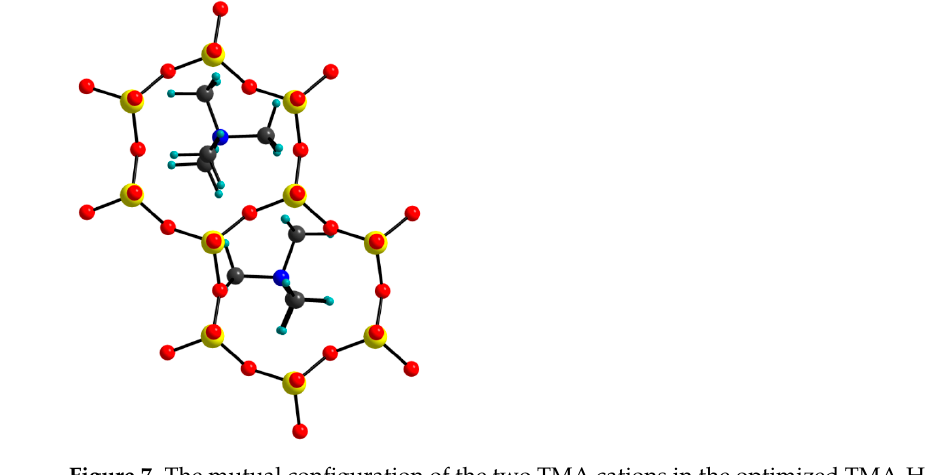
Figure 7. The mutual configuration of the two TMA cations in the optimized TMA-H structure, c * view, L model.